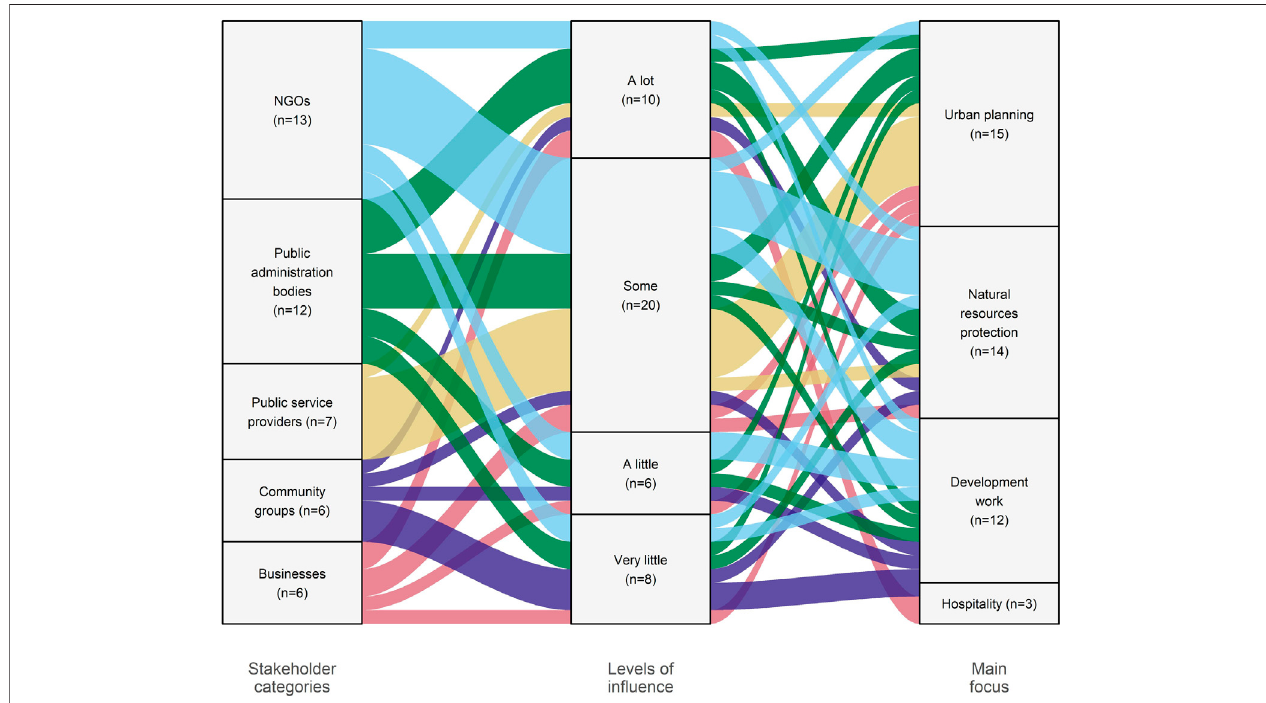
FIGURE 2 | Stakeholders ’ pro fi les, including their category, self-assigned level of in fl uence and the main focus of their organisation. Colours of the fl ows are representative of the stakeholder categories.